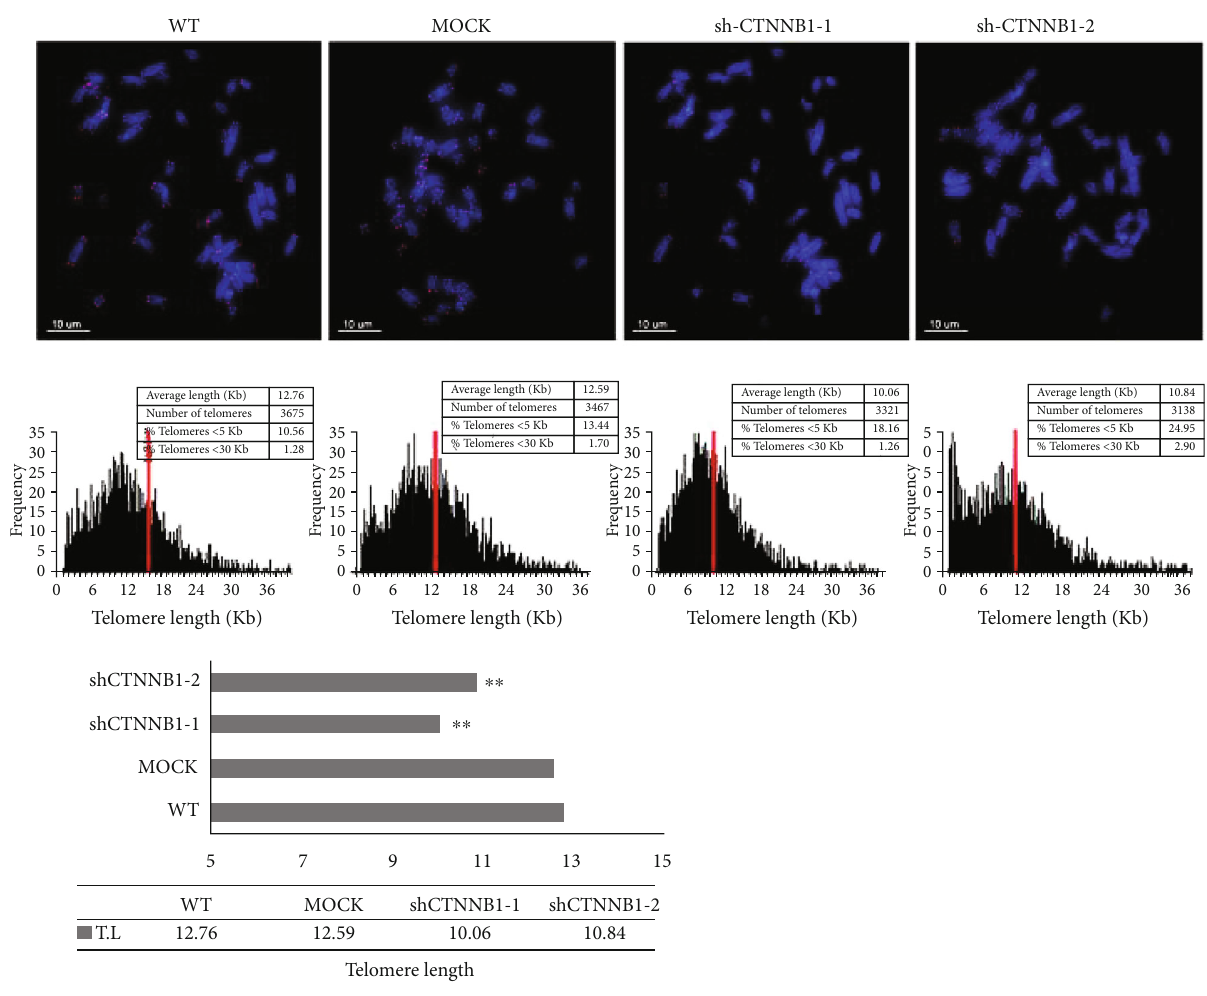
Figure 4: shCTNNB1 hESCs exhibit low cell proliferation and decreased telomere length as compared to WT cells. (a) Cell growth curves of shCTNNB1, MOCK, and WT hESCs. The data are represented as an average of two independent experiments ( n = 2 ). (b) Cell cycle analysis of shCTNNB1, MOCK, and WT hESCs. (c) Wound-healing assay. Wounds were created by manual scraping the cell clones, and images were captured as the reference point. The image of the healing state was acquired after 18h ( scalebar = 200 μ m ). (d) Decreased telomerase activity in shCTNNB1 cells. Heated HSF and WT cell lysates were used as negative controls. (e) Telomere length in shCTNNB1 hESCs. Metaphase cells from the indicated groups were analyzed by the quantitative telomere-FISH assay. Strand-speci fi c telomeric DNA probes (red) show telomere repeats; the nuclei were stained with DAPI (blue). Telomere length is represented in arbitrary units of fl uorescence (a.u.) ( scale bar = 10 μ m ). The histograms show the frequency of di ff erent telomere lengths in CTNNB1 -silenced hESCs. The results are represented as an average of two or more independent experiments. Error bars indicate mean ± SD from three independent experiments ( n = 3 , ∗ p < 0 : 05 , ∗∗ p < 0 : 01 , relative to WT